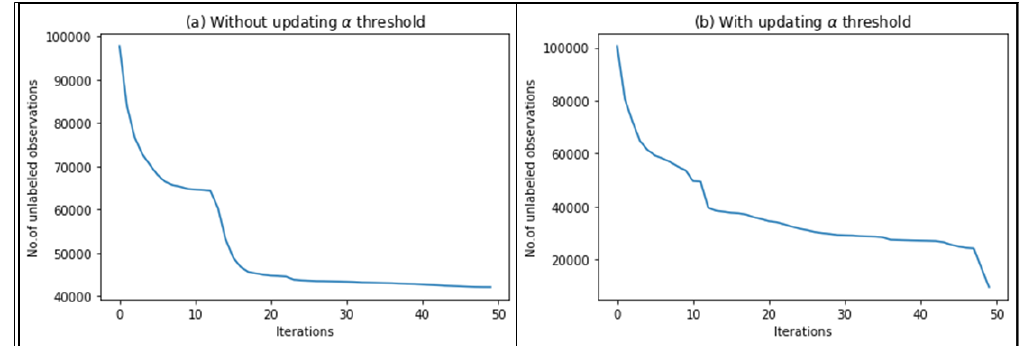
Figure 5. Relation between the number of iterations and α .